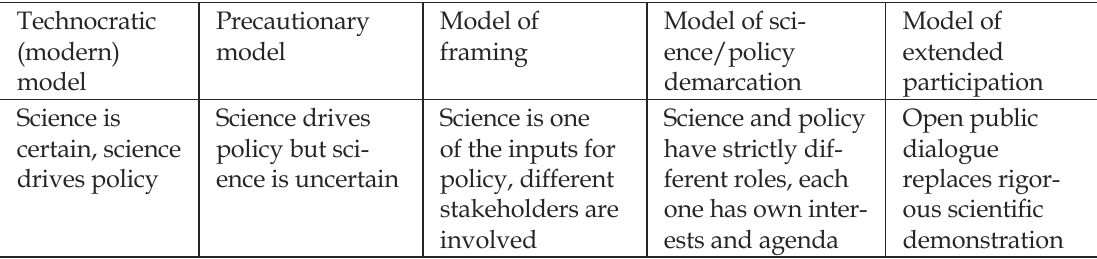
Table 2. Scheme with some features of Funtowicz’s model of science-policy interactions (Funtowicz,